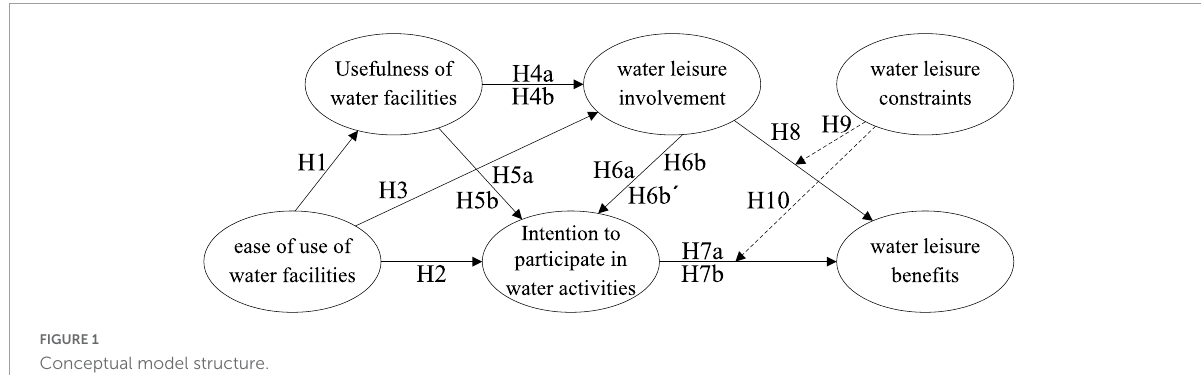
FIGURE1 Conceptual model